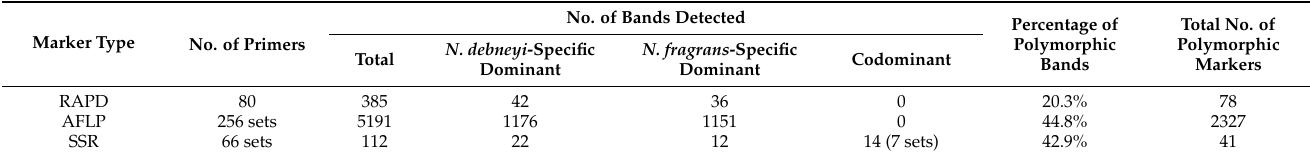
Table 1. Polymorphic markers detected by RAPD, AFLP, and SSR